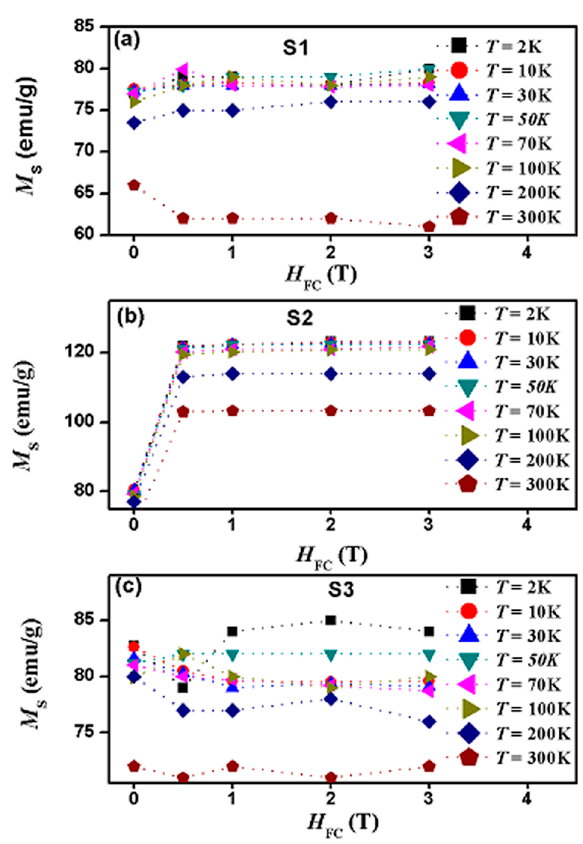
Figure 5. The saturation magnetization versus field-cooling value at several temperatures (from 2 to 300 K) for each sample ( a ) S1, ( b ) S2, and ( c ) S3.